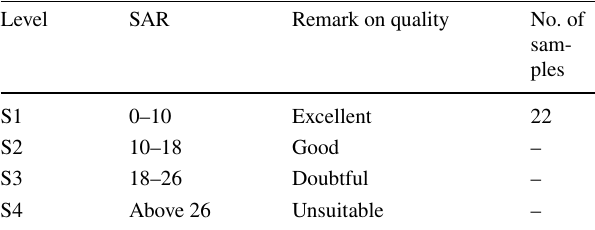
Table 5 Irrigation water quality classification based on SAR (Todd